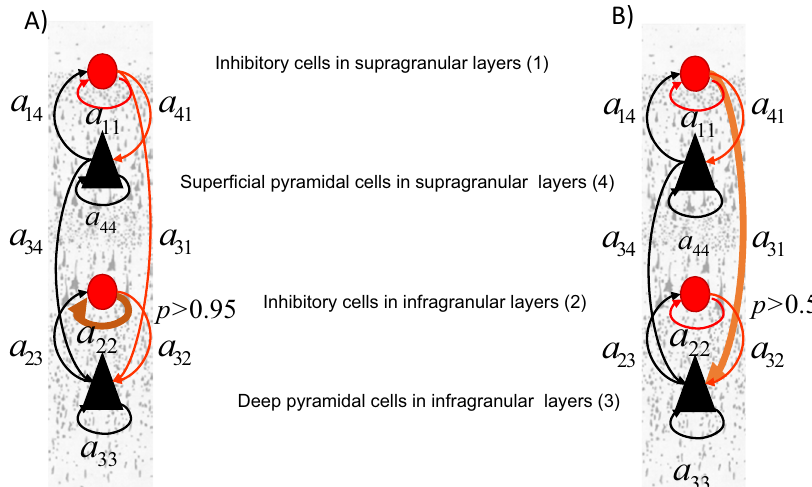
Fig. 6 V1 size predictors. a We scored alternative GLMs where predictors of variability in V1 included any combination of the connections (arrows) in Fig. 1a. We found that for the data from ref. 15 V1 size could be best predicted by the recurrent connectivity of deep inhibitory interneurons, a 22 (brown arrow). Evidence in favour of a GLM including a 22 was very strong p > 0.95. b Same as in a for data from ref. 20 . V1 size variability reported in ref. 20 could be best predicted by the inhibitory drive to deep pyramidal cells, a 31 (brown arrow). Evidence for the corresponding GLM was weak p >